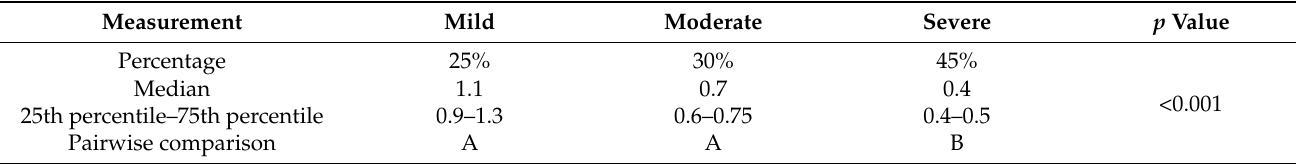
Table 7. Changes in CSA after 1, 3, and 6 months.